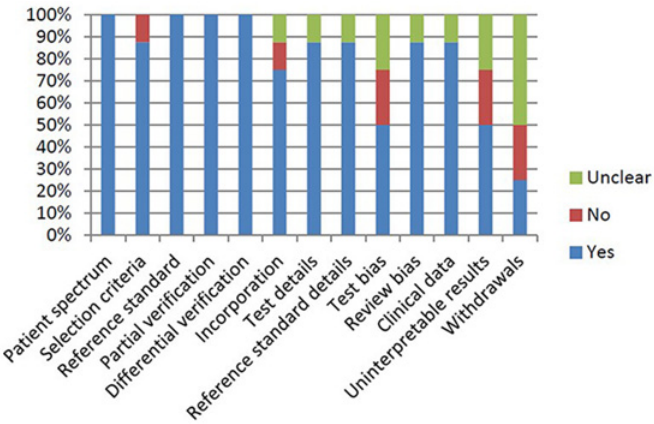
Fig 2. Results of quality assessment for appropriate patient spectrum studies.